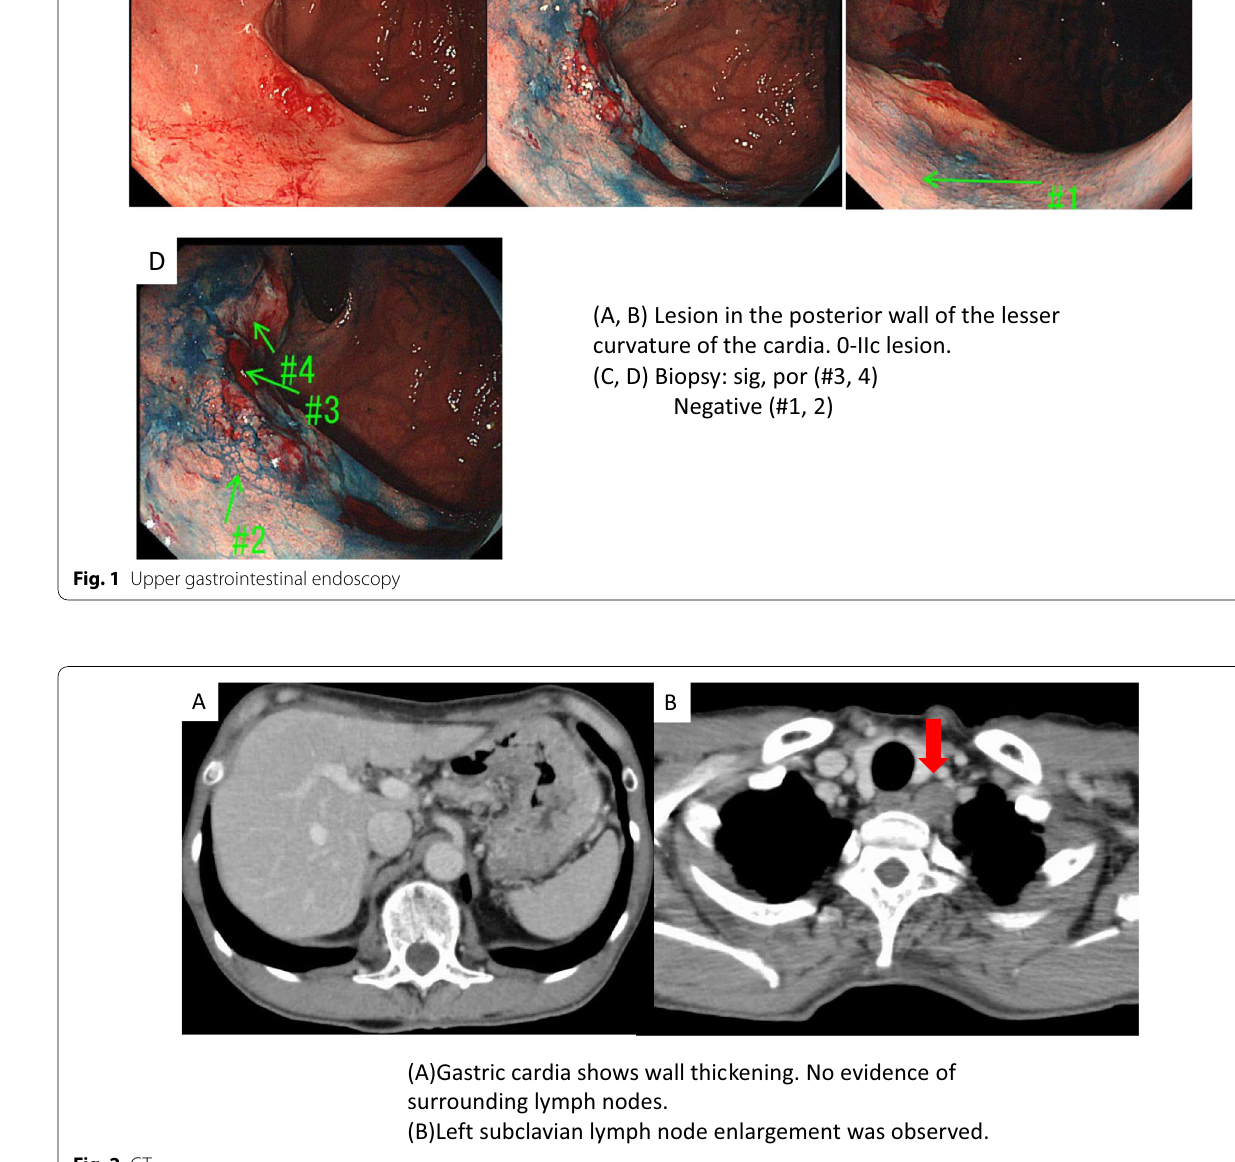
emission tomography-CT (PET-CT) scan showed mild FDG accumulation in the same lymph node (SUV- max 3.7 ), which was suspected as a Virchow metastasis. (Figs. 2, 3).